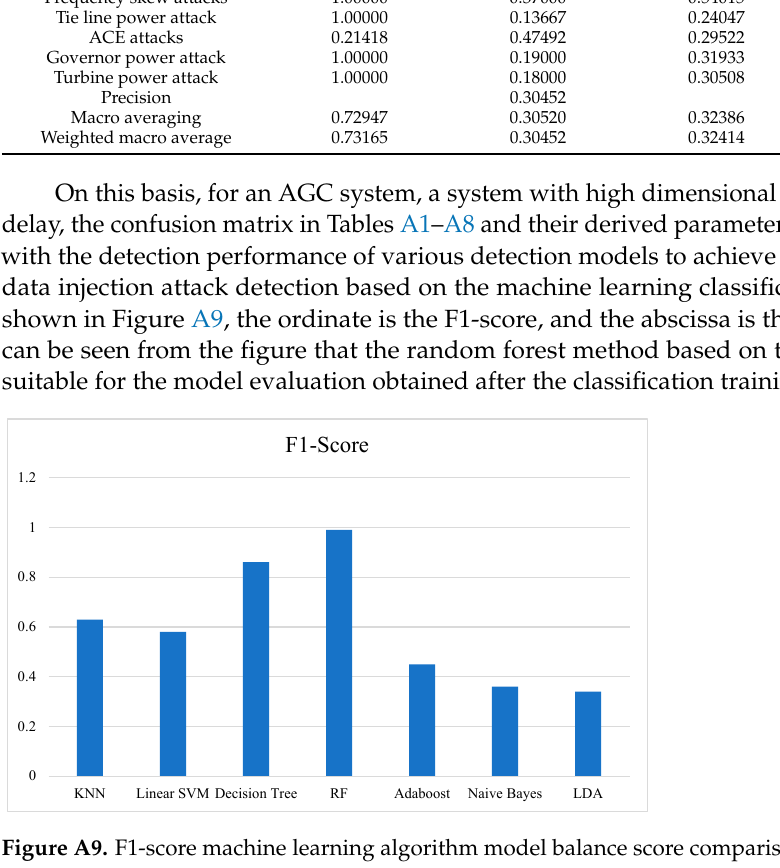
Table A8. The LDA algorithm trained on model indicator data. LDA Precision Recall F1 Score Test Samples